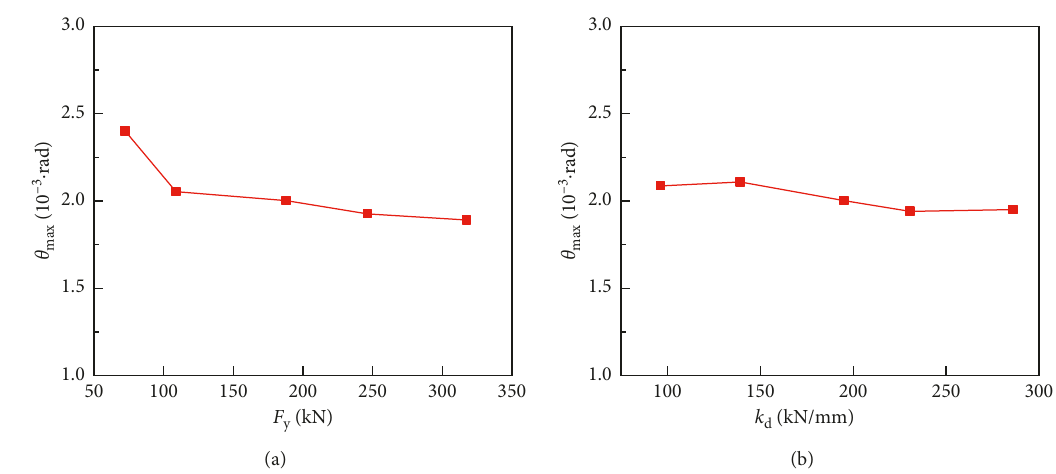
Figure 19: Effects of the parameters regarding the dampers. (a) F